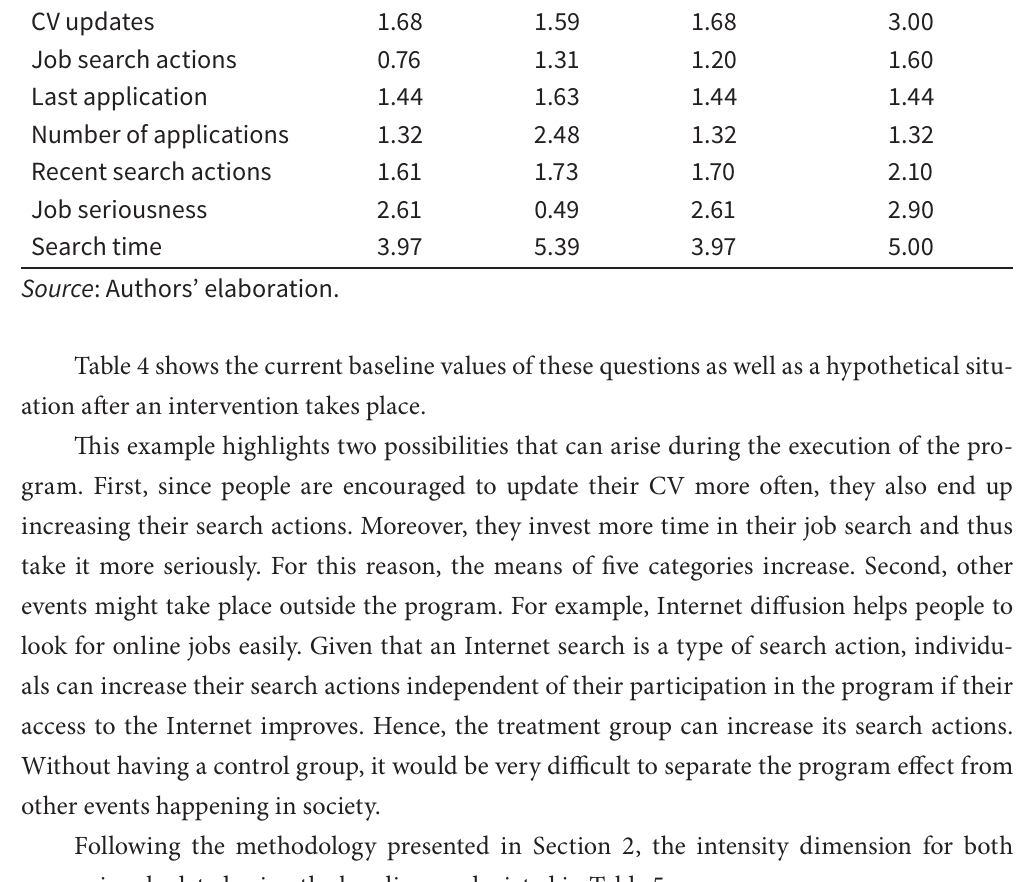
Table 4 Baseline and assumptions on control and treatment outcomes Baseline (B) Control (C) Treatment (T) Question Mean